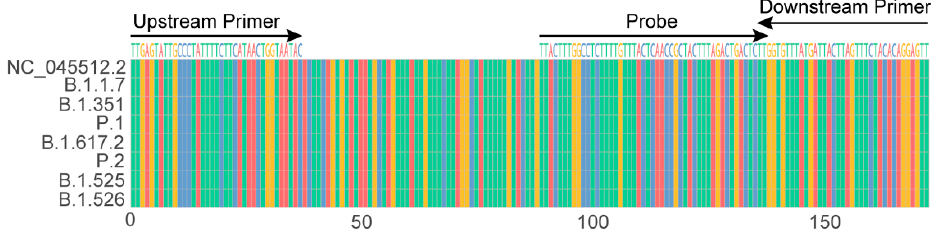
Figure 1. Sequence alignment of 172 targeted sequence among SARS-CoV-2 strain NC_045512.2 (GenBank Accession No.), four VOCs (B.1.1.7, B.1.351, P.1 and B.1.617.2) and three VOIs (P.2, B.1.525 and B.1.526).